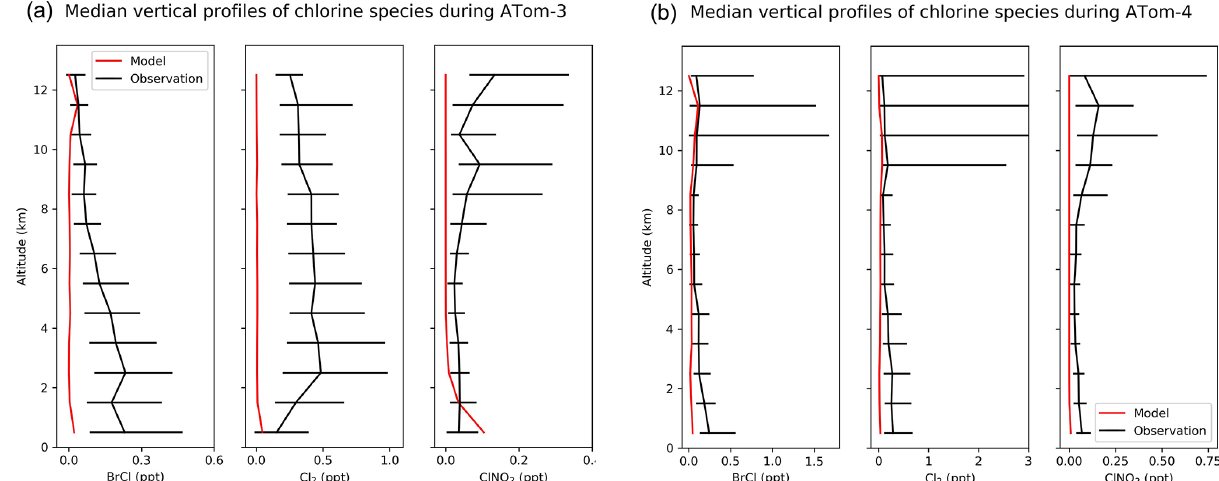
Figure 10. (a) Vertical profiles of BrCl, Cl 2 , and ClNO 2 mixing ratios from the ATom-3 campaign over the Pacific and Atlantic in September– October 2017. Observations are medians and 25th–75th percentiles in 1km vertical bins. Model values are medians sampled along the flight tracks. (b) Same as Fig. 10a but for the Atom-4 campaign in April–May